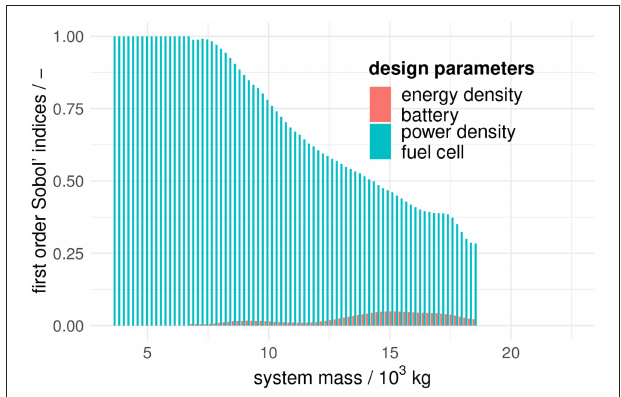
FIGURE 9 | First order Sobol’ indices of the two technology performance parameters for the minimized system